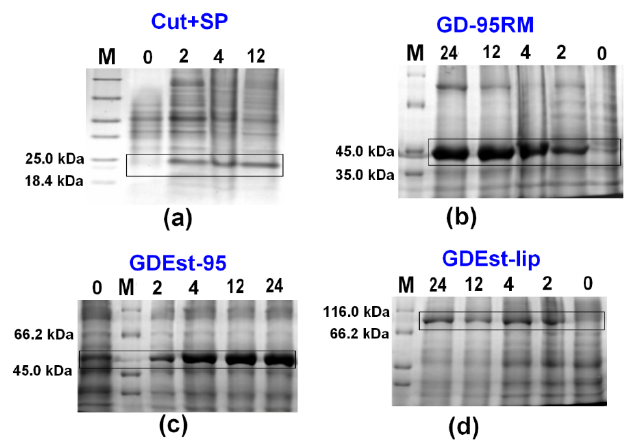
Figure 5. Analysis of production of recombinant Cut+SP ( a ), GD-95RM ( b ), GDEst-95 ( c ) and GDEst-lip ( d ) enzymes in 1 L mM9 cultivation medium without additional supplementation with ampicillin and using MP (4mM) as an inducer. M—Pierce™ Unstained Protein MW Marker; 0/2/4/12/24— time point after induction with MP (in hours). The target enzymes are marked with black boxes. Tricine-SDS-PAGE was used for Cut+SP analysis and glycine-SDS-PAGE for GD-95RM, GDEst-95, and GDEst-lip.